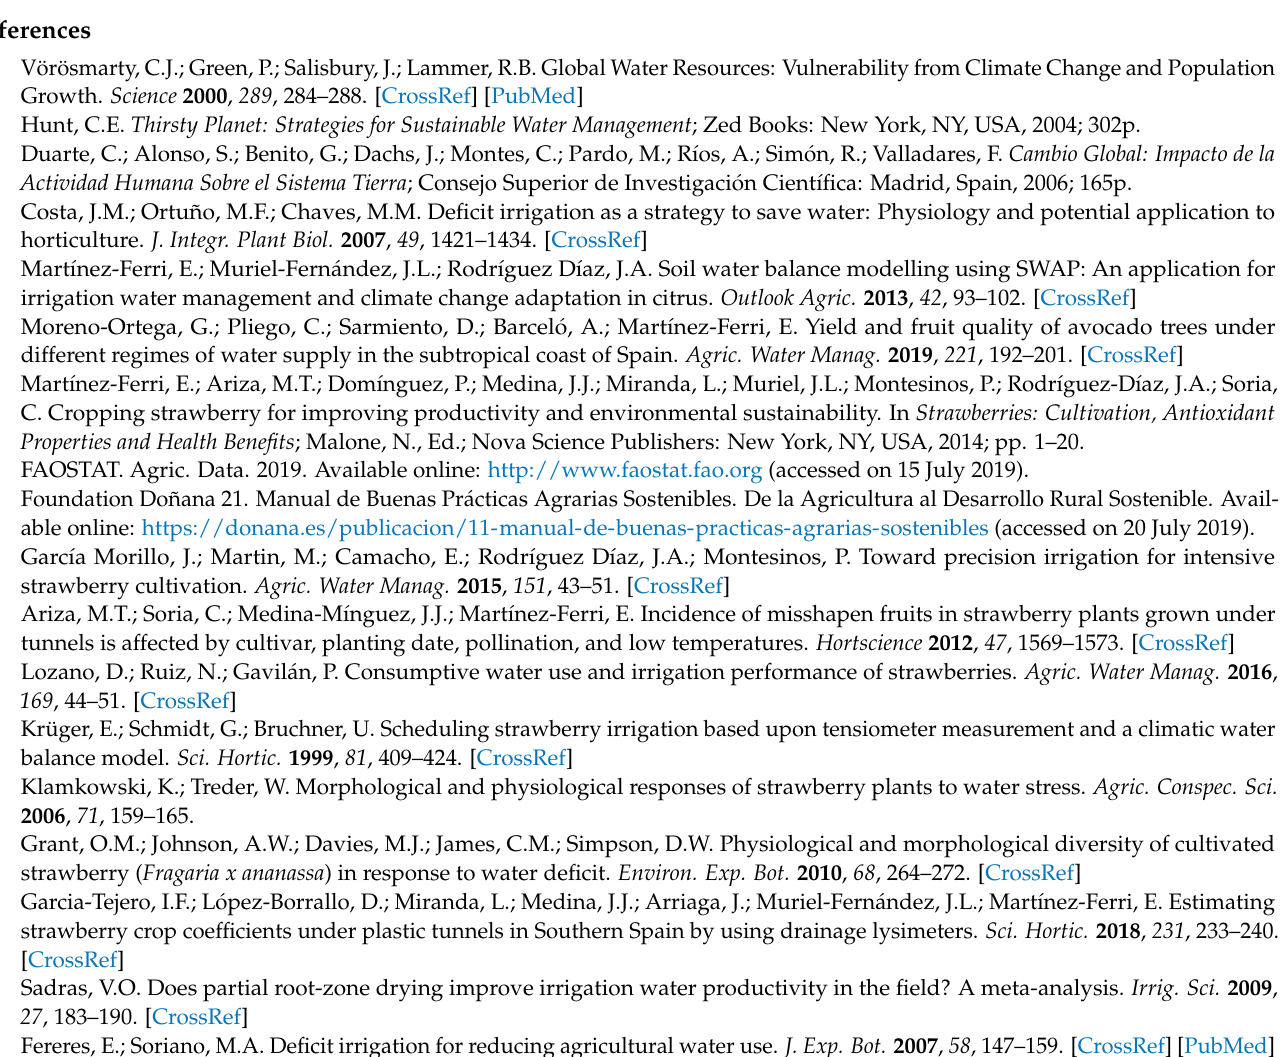
Figure A2. Variation of cumulated ET c